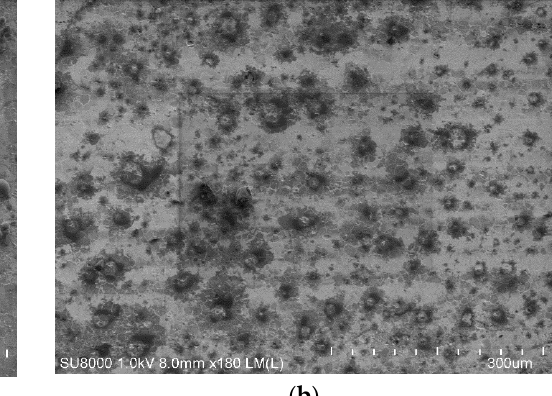
Figure 15. ( a , b ) SEM images of the AZ61/SiCp MMCs extruded plates before annealing (10 μ m SiC with 5 wt %) both with *250; ( c ) Test area for EDX analysis of the AZ61/SiCp MMCs extruded plates before annealing (10 μ m SiC with 5 wt %); ( d ) Element results from EDX analysis of the AZ61/SiCp MMCs extruded plates before annealing (10 μ m SiC with 5 wt %).